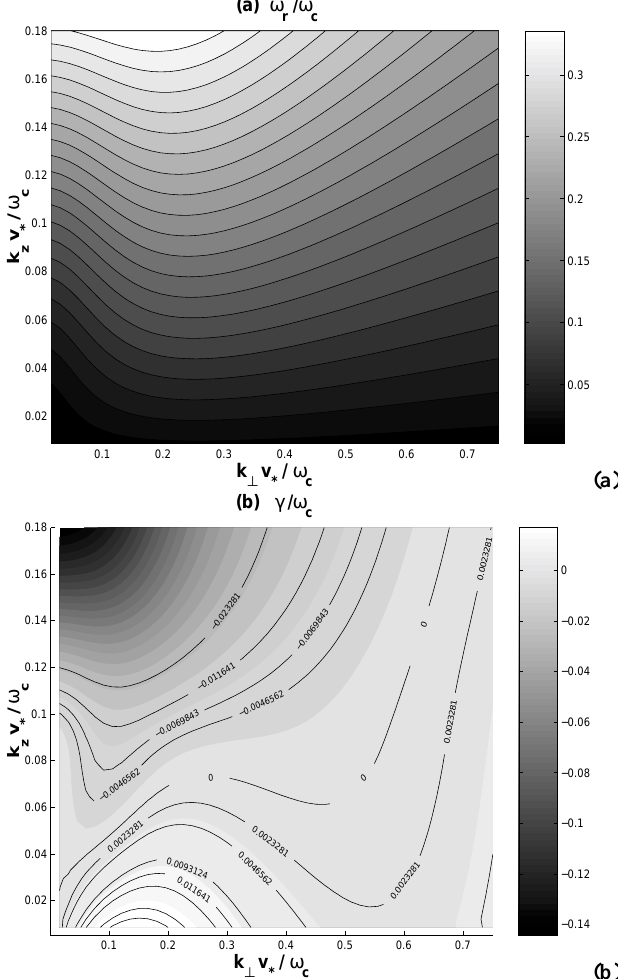
Fig. 2. Numerical calculations for solar wind plasma conditions: contour lines of constant level of (a) the normalized frequency ω r /ω c as a function of the normalized parallel and perpendicu- lar wave numbers k z v ∗ /ω c and k ⊥ v ∗ /ω c , and (b) the normalized growth rate γ/ω c as a function of k z v ∗ /ω c and k ⊥ v ∗ /ω c . The solar wind parameters are: ω p /ω c ’ 130 , ω c / 2 π ’ 100Hz, ω p / 2 π ’ 13kHz, T e ’ 15eV, T e /T i ’ 4 . For (b), the values of the calculated growth rates are indicated on the